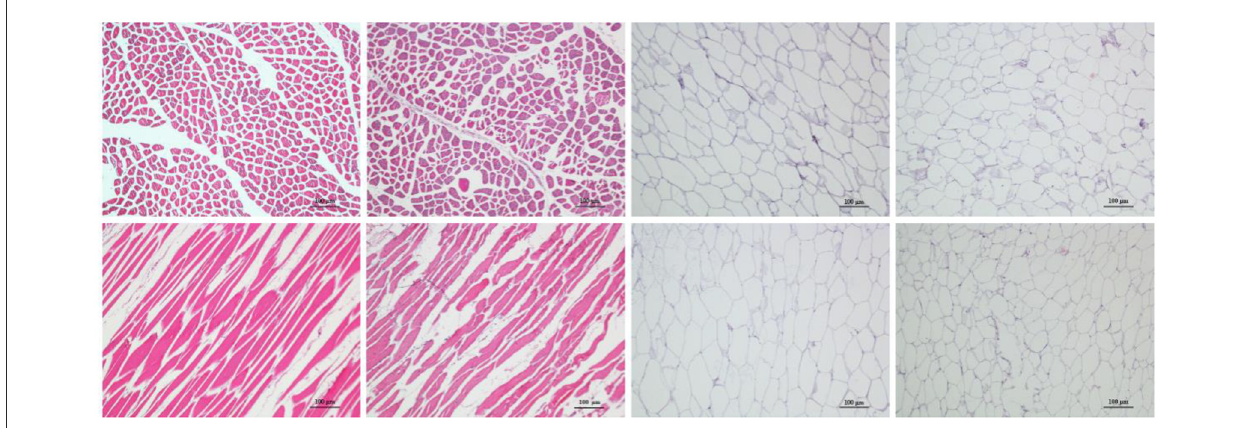
FIGURE1 Representative sections from four meat samples by hematoxylin and eosin (H&E) staining ( × 100). From left to right: Longissimus lumborum of camel and beef, hump, and fatty-tails. Top: cross-sections; bottom: longitudinal sections. The scale bar represents 100 µ